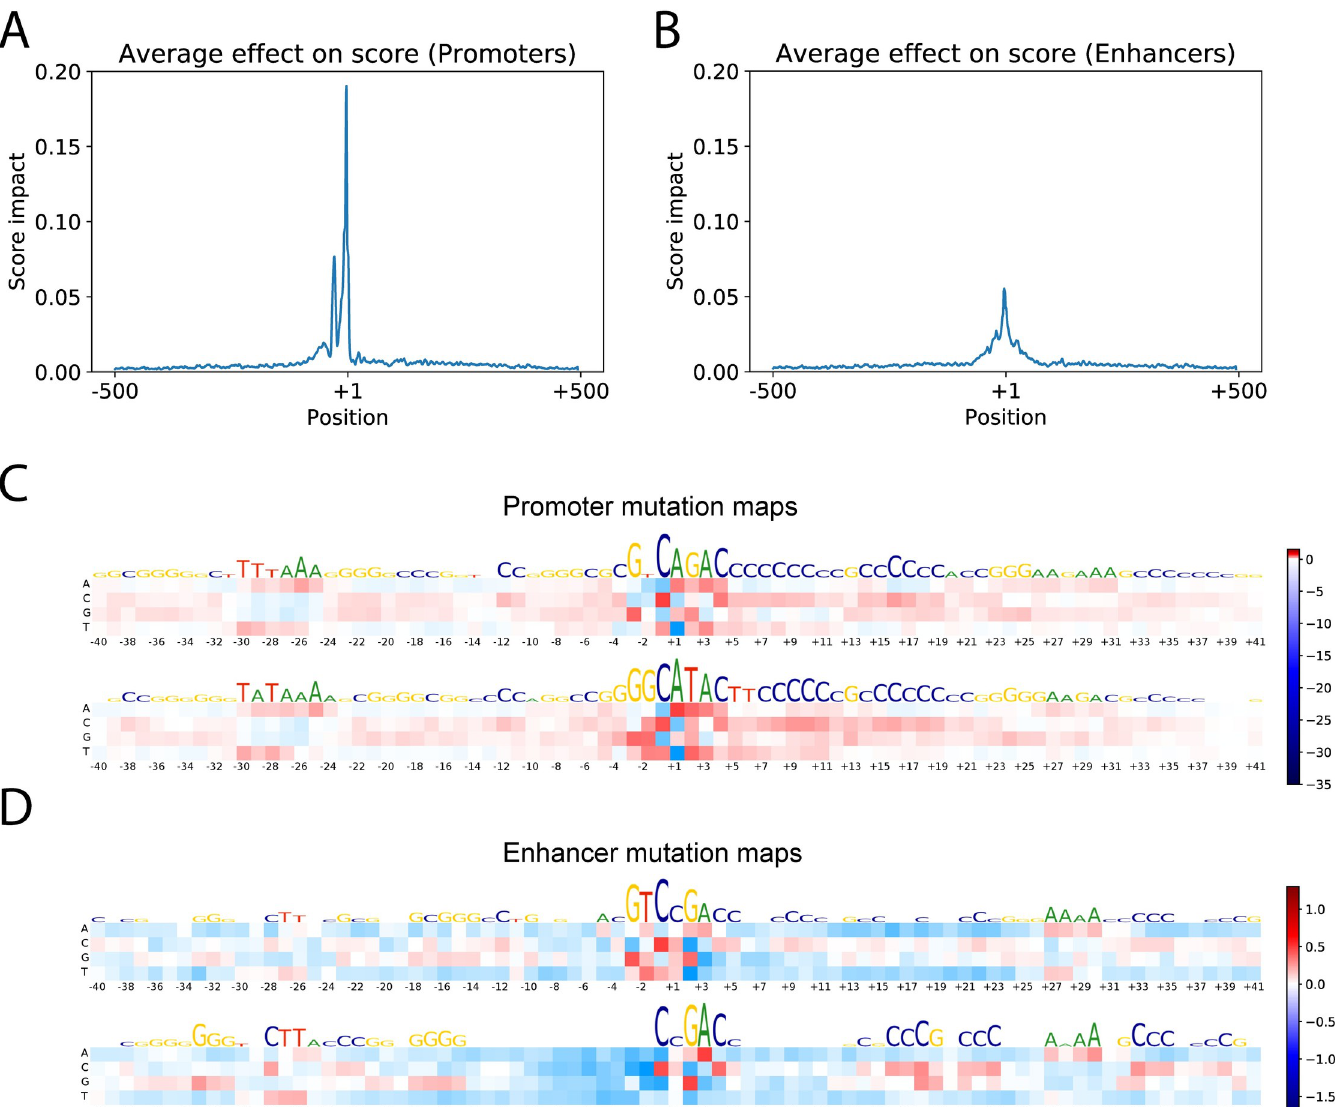
Fig 4. Analysis of the trained model. ( A ): Effect of 7 bp sequence window substitution by a random sequence on the predicted score of the promoters. ( B ): The same substitution procedure applied to the enhancer sequences. ( C ): Mutation maps for the promoter sequences. K-means with k = 10 was applied to the mutation matrices before averaging and the two biggest clusters are shown. ( D ): Mutation maps for the two biggest clusters of enhancer mutation matrices. how nucleotide substitutions will change the output score computed by our model. At each position of the tested sequences, we replaced a nucleotide with a different one in all the sequences and computed their average score change. The rows represent nucleotides that are used for replacement and the columns show different positions inside the regulatory regions. If the new score on average increases, it is represented by a red-colored square. Decreasing the score is shown by using a blue-colored square. The intensity of color is proportional to the